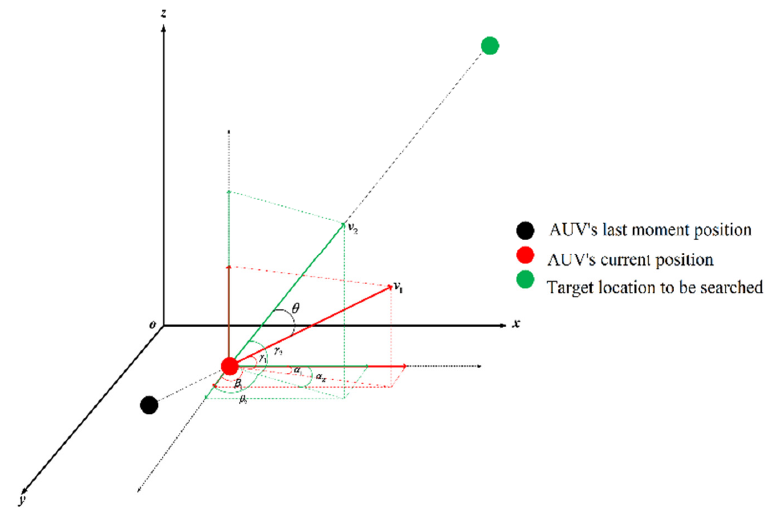
Figure 8. Speed angle diagram of AUV. The speed direction v 1 of the AUV at the current position can be calculated by the position of the last step of the AUV and the current position of the AUV, and the expected speed direction v 2 of the AUV can be calculated by the current position of the AUV and the target position for the AUV to search. The angle θ between v 1 and v 2 is calculated according to the relative positions between the three. The speed of the AUV’s position at the next moment is set as v 0 , then v 0 . satisfies the condition of Formula (29):